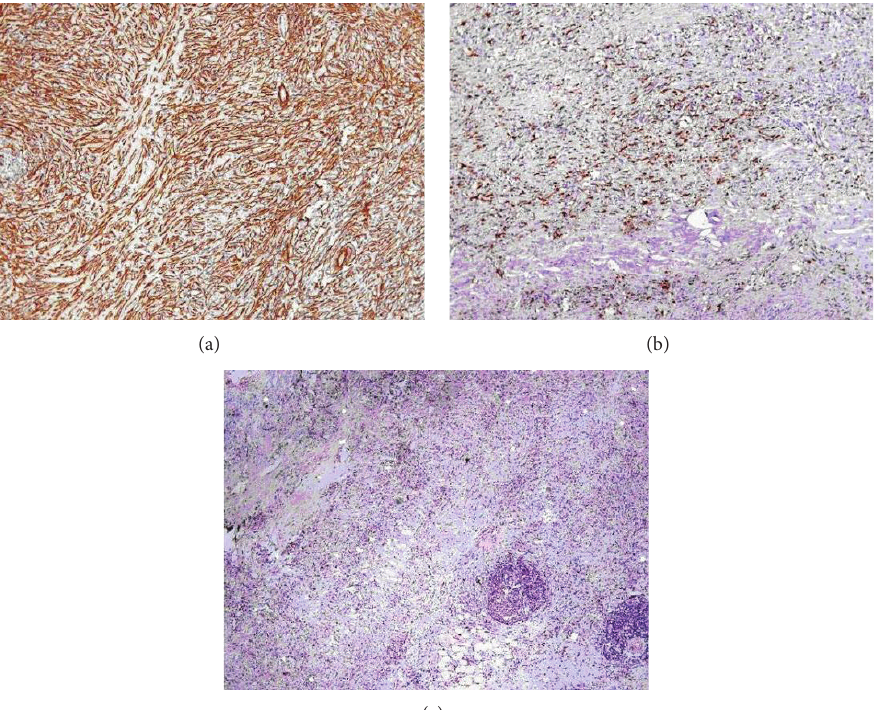
Figure2:ImmunohistochemistryfeaturingIMTcharacteristics:diffuselypositiveforactin,locallypositiveforFXIIIa,andnegativeforCD34.